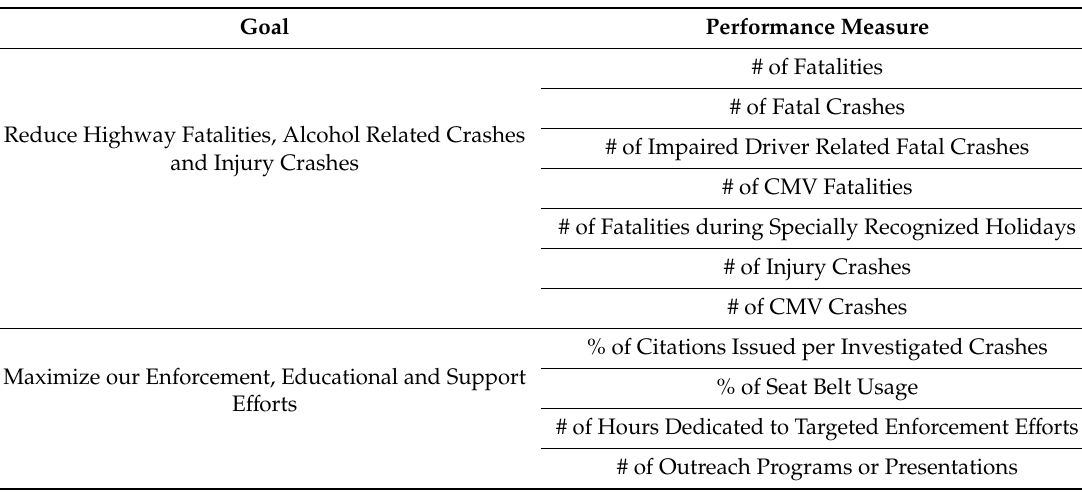
Table 1. Wyoming Highway Patrol (WHP)’s performance measures in two balanced scorecard categories